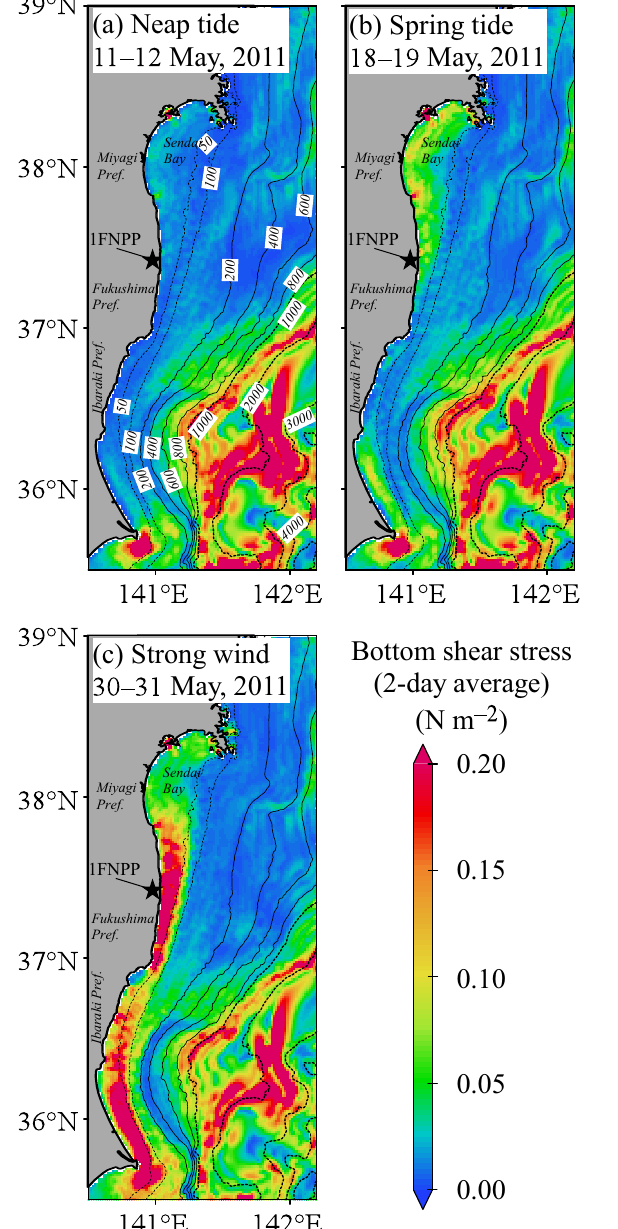
Figure 10. Simulated spatial distributions of 2-day averages of bot- tom shear stress for events of (a) spring tide (11–12 May 2011), (b) neap tide (18–19 May 2011), and (c) strong wind (30–31 May 2011). Black star indicates location of 1FNPP. Contours show water depth (m) according to JTOPO30 (MIRC). lated concentrations of sediment-surface 137 Cs were roughly comparable with observations except for overestimation to the northeast of 1FNPP. However, this agreement could not validate 137 Cs migration flux from seawater to sediment.